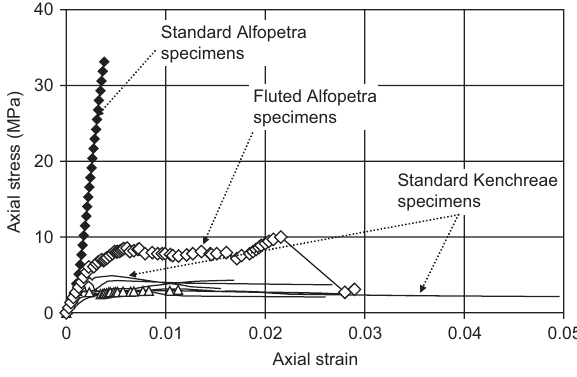
Figure 15 Comparison between standard and fl uted specimen from Alfopetra